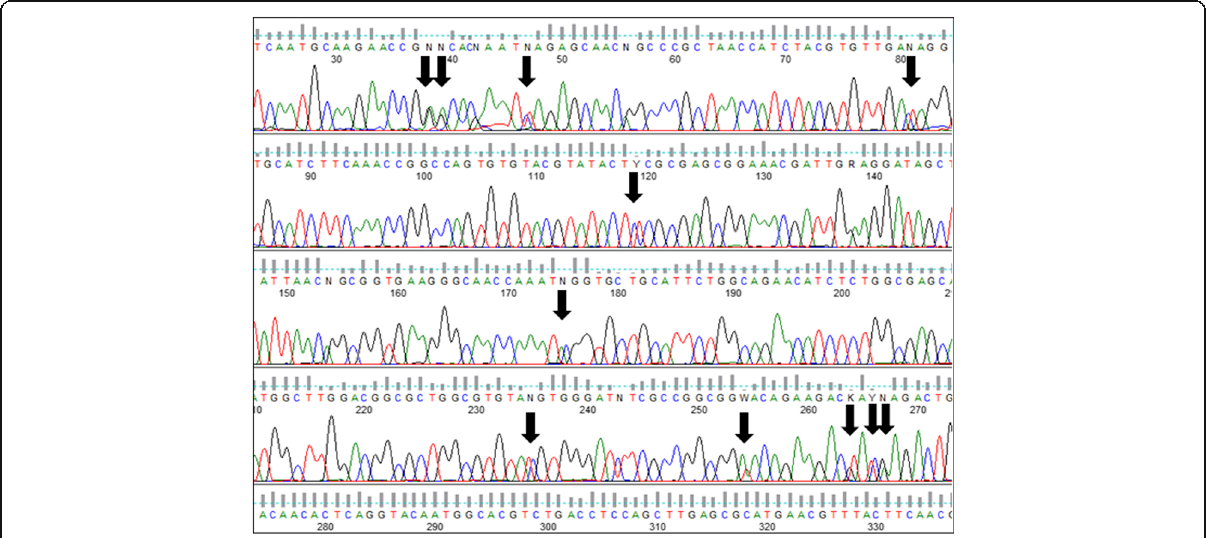
Fig. 3 Chromatogram of the β -tubulin – coding gene showing the double peaks due to the presence of different gene